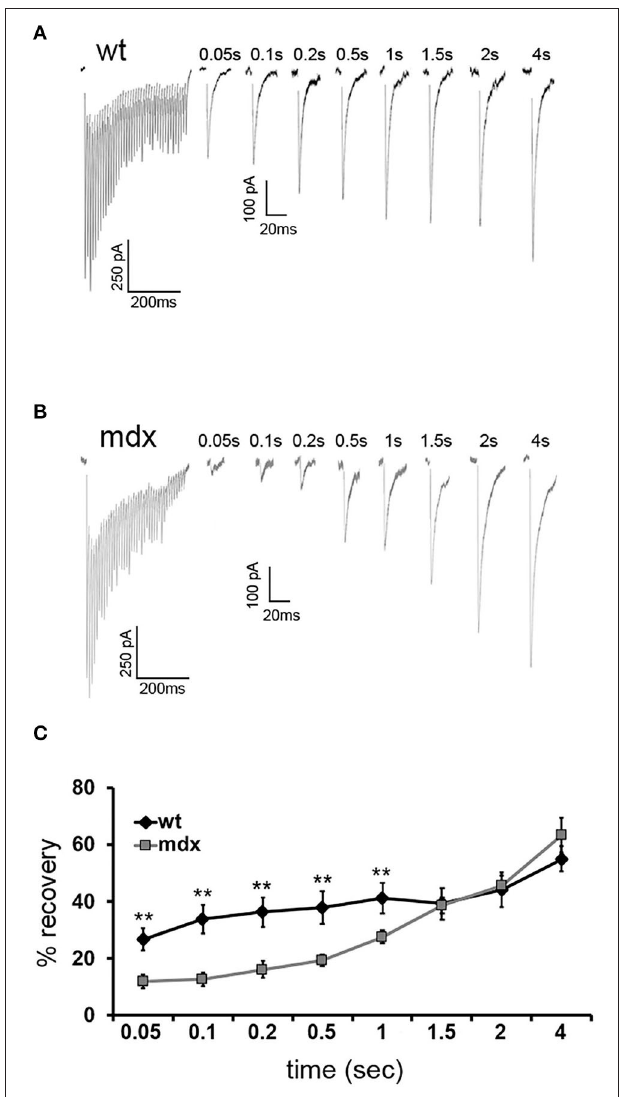
FIGURE 4 | Recovery from short-term depression is slower in mdx CbN neurons. Representative traces of IPSCs evoked by a 100-Hz stimulus train followed by single IPSCs after a delay of 0.05–4s from wild-type (A) and mdx (B) CbN neurons. Scale bar (100Hz stimulation): 250pA, 200ms. Scale bar (IPSC recovery): 100pA, 20ms. (C) Summary graph of normalized mean recovery of IPSC amplitudes following 100Hz stimulation from wild-type (black diamonds, n = 10 cells, 2 animals) and mdx (gray squares, n = 18 cells, 4 animals) cells. Traces are averages of 6–10 trials. Error bars indicate SEM. ** p ≤